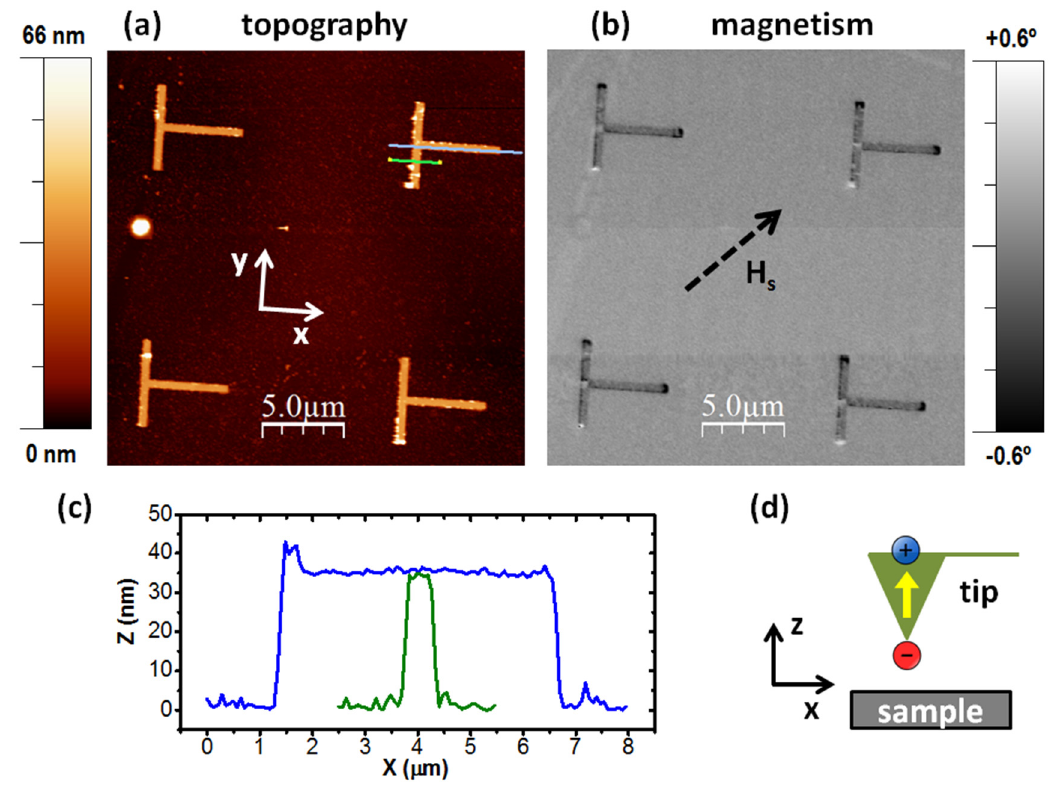
Figure 2. ( a ) Topographic and ( b ) magnetic images, respectively, of four T-shaped structures. ( c ) Topographic profiles along the blue and green lines painted in ( a ). ( d ) Scheme of the magnetic state of the tip.